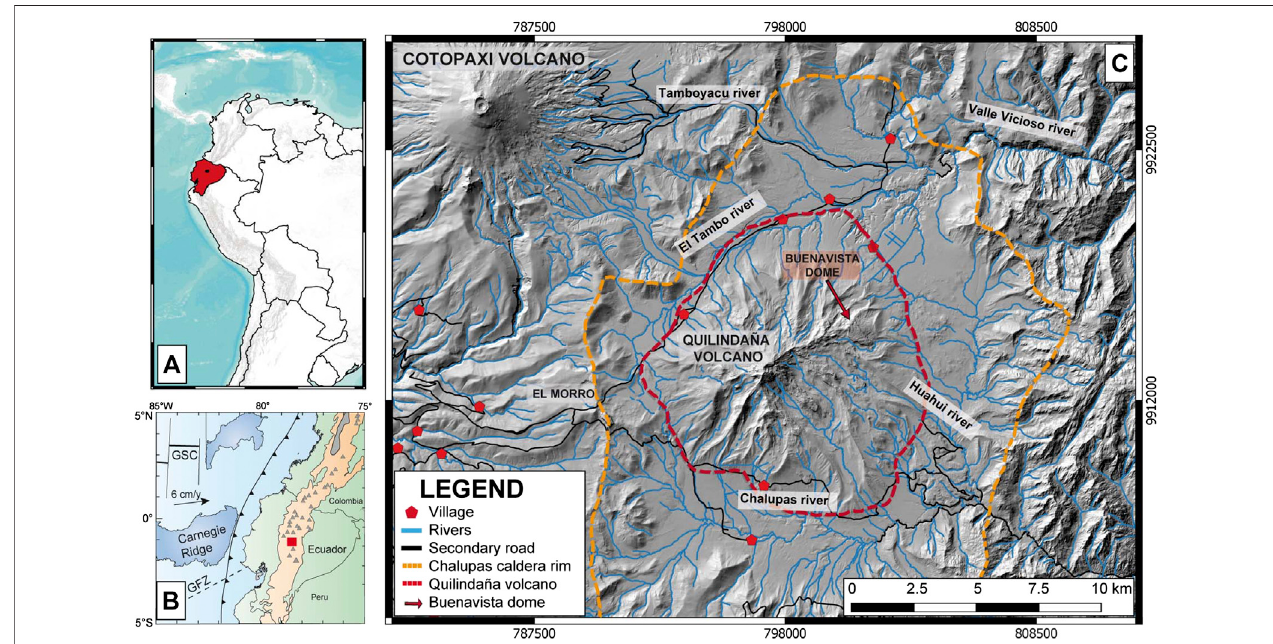
FIGURE 1 | Location of Chalupas caldera. (A) Ecuador. (B) Geodynamic framework of the Ecuadorian volcanic arc at the convergence of the Nazca and South American plates, converging eastward at 6 cm/years (White et al., 2003). The trench is represented by the black line with indents, GSC, Galápagos Spreading Center; GFZ, Grijalva Fracture Zone (modi fi ed from Robin et al., 2010). Chalupas caldera is represented by a red square. (C) Chalupas caldera in the local context with its topographic rim and the perimeter of Quilindaña volcano.